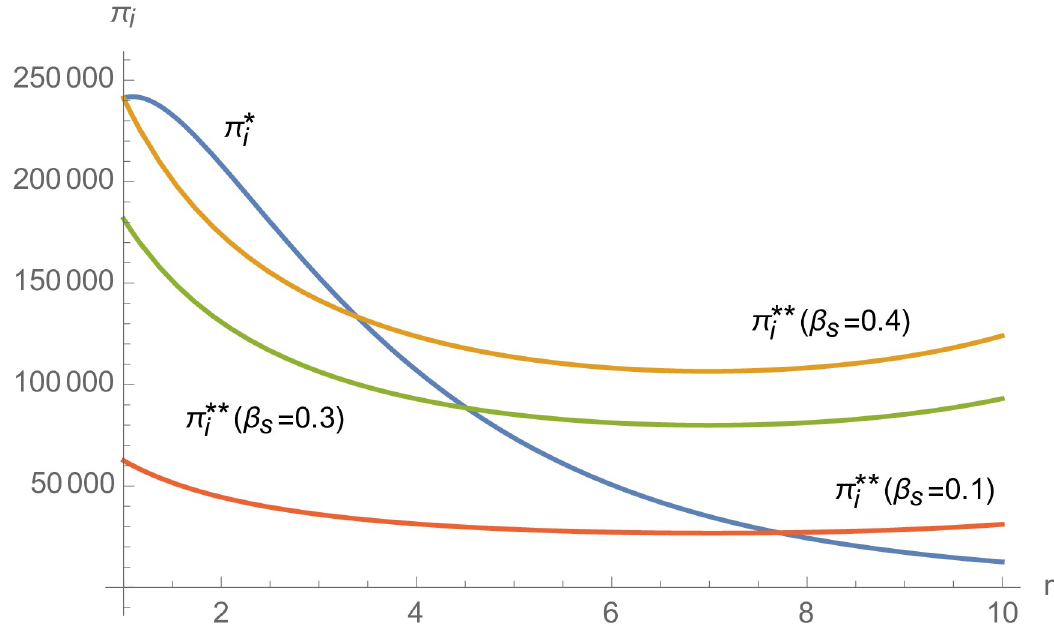
Fig 38. The impact of n on π